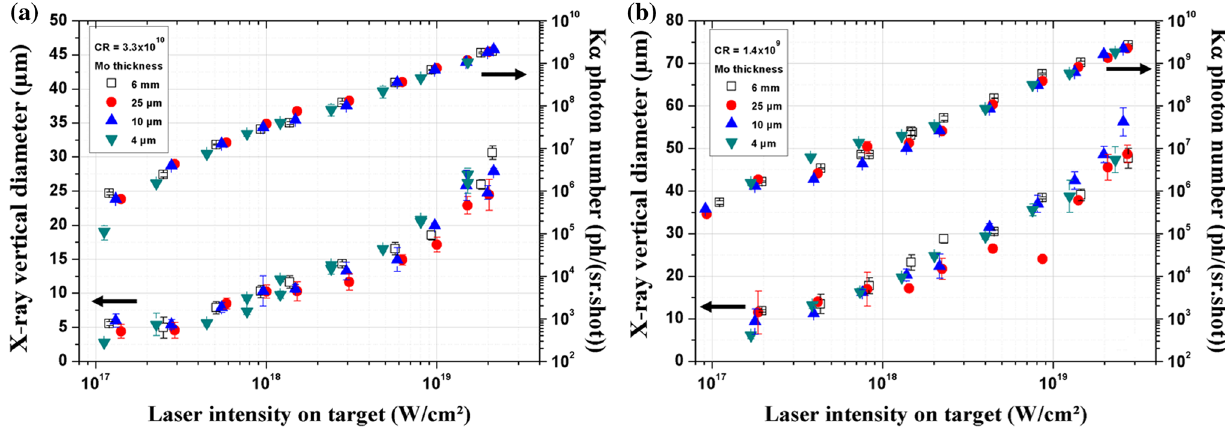
Figure 4. Comparison of the x-ray vertical source size and the Kα photon number versus laser intensity between a 6 mm massive Mo target and Mo foil targets of 25 µm, 10 µm and 4 µm thickness. For CR = 3.3 × 10 10 in ( a ) and for CR = 1.4 × 10 9 in ( b